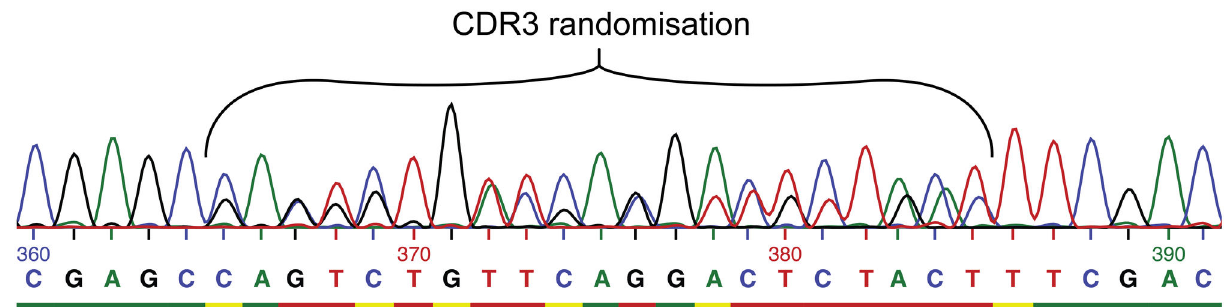
Figure 5. Trace data from sequencing of “double read” clone. The trace data from the CDR3 randomized region of one of the clones we define as having a double read. We found the trace data to be unusual as there was a perfect read both before and after the CDR3 region. Furthermore the trace data indicate that there are two very clearly defined reads mixed together in the region.